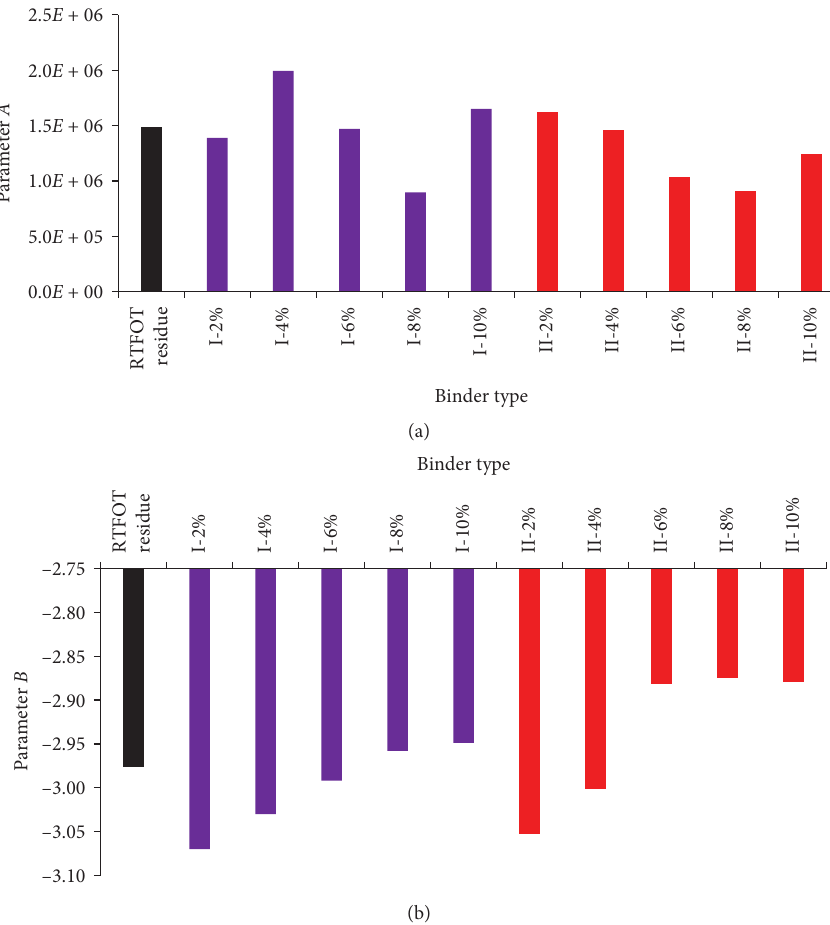
Figure 8: LAS test results. (a) Fatigue parameter A; (b) fatigue parameter B.